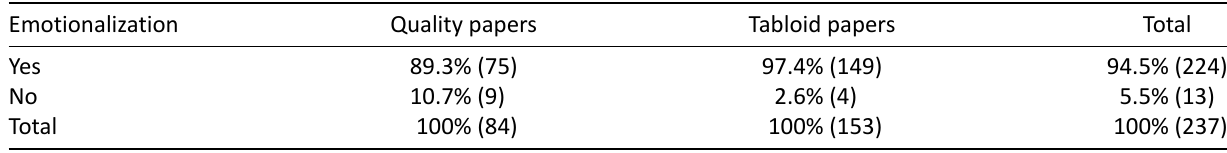
Table 3. Emotionalization in quality and tabloid